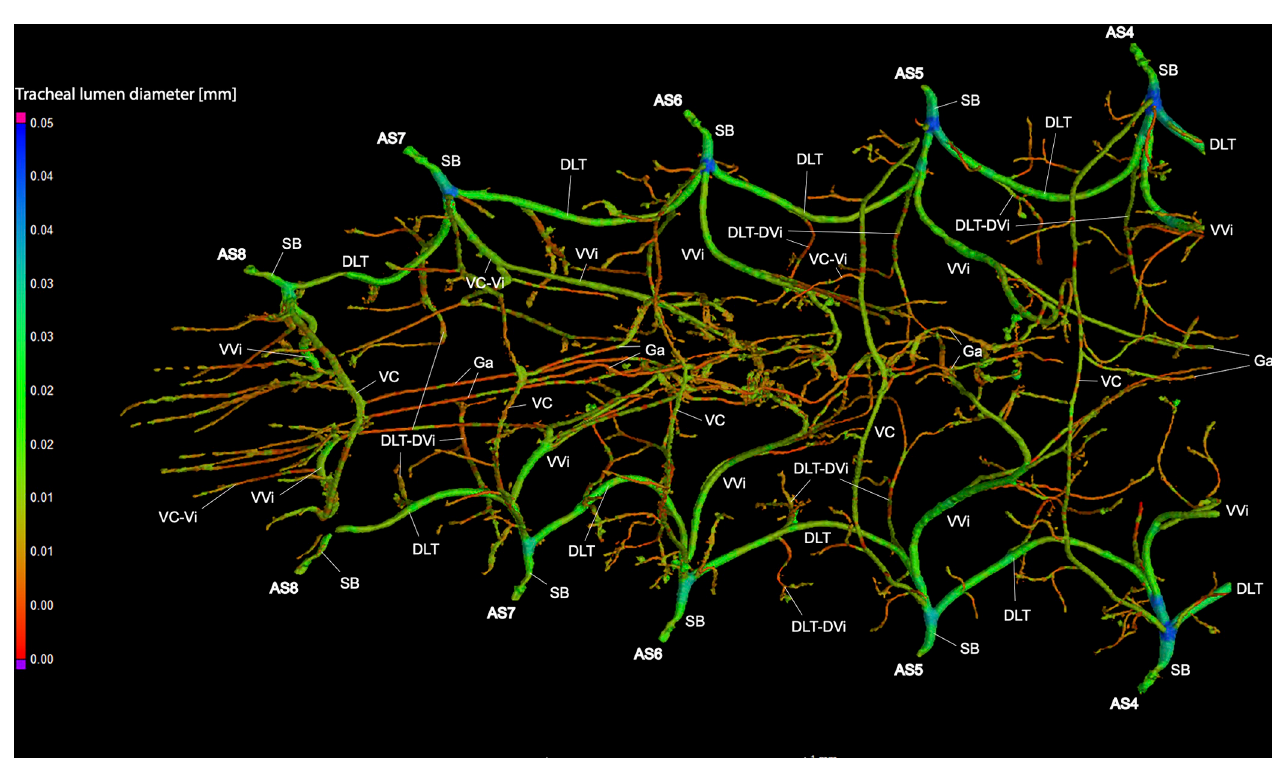
Fig 7. Ventral view of the abdominal tracheal system in Photinus pyralis 3–4 day-old pupa.